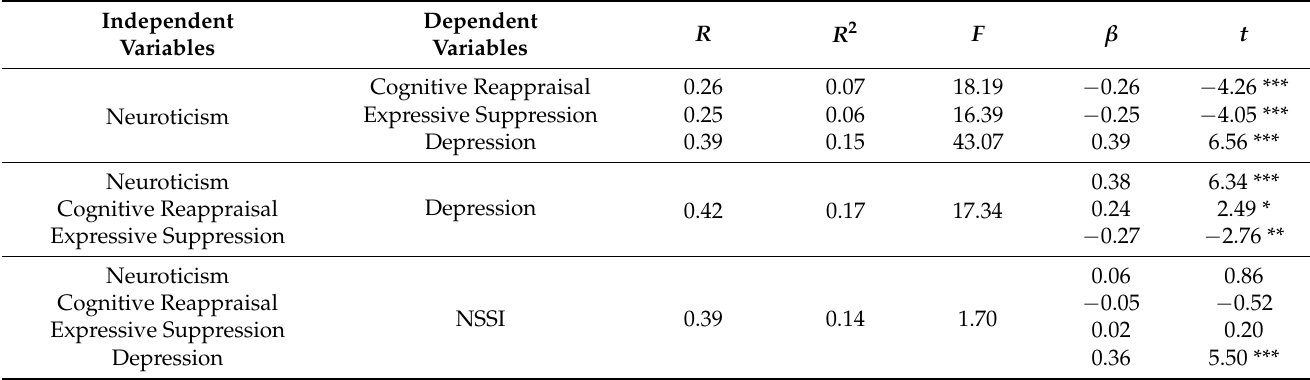
Table 5. Multivariate regression analysis of neuroticism, emotion regulation (ER), depression, and NSSI among female college